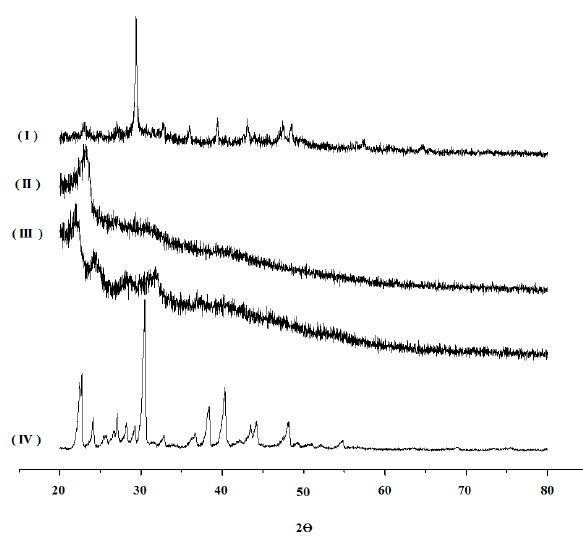
Figure 7. X-ray di ff ractograms of pure 5-ASA (IV), Formulation XBM-Ca-F9 without drug (III), xylan Figure 7. X-ray diffractograms of pure 5-ASA (IV), Formulation XBM-Ca-F9 without drug (III), xylan (II), and Formulation XBM-Ca-F9 loaded with 5-ASA (II), and Formulation XBM-Ca-F9 loaded with 5-ASA (I).